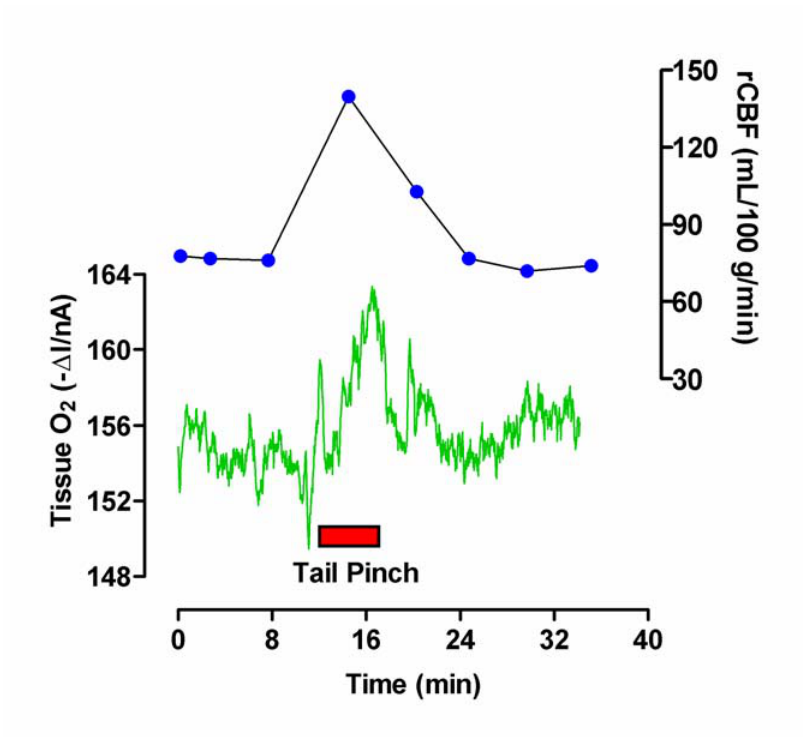
Figure 2. Typical examples of raw data obtained for the measurement of tissue O 2 and blood flow (rCBF), monitored simultaneously with bilaterally implanted carbon paste (O 2 ) and Pt/Ir (H 2 clearance) electrodes in the striatum of a freely-moving rat, in response to behavioral stimulation (5-min tail